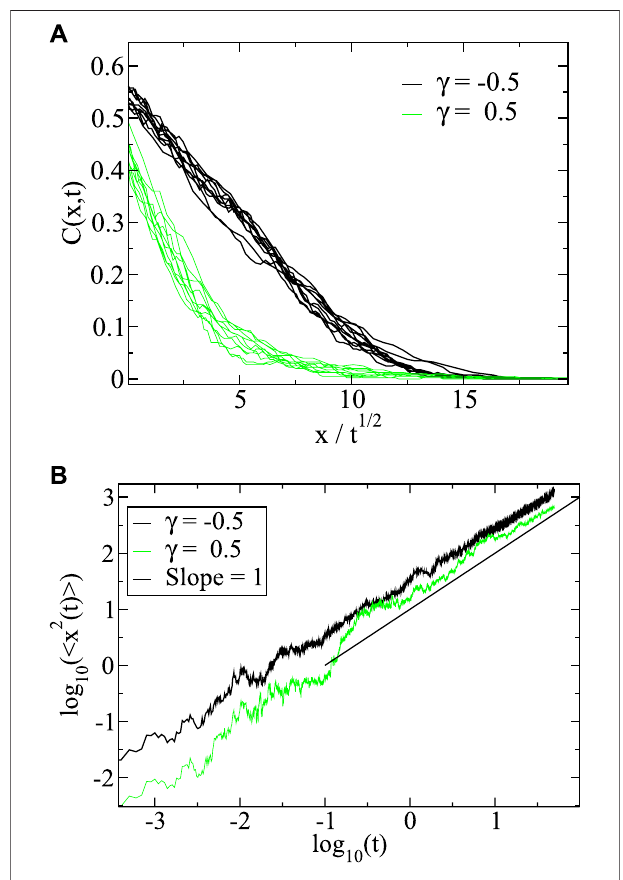
FIGURE1|(A) Evolutionofthesteppro fi lewhen c (cid:2) ± 1 / 2asafunction (cid:6) √ of x / t at different times. (B) The corresponding right-handed 〈 x 2 ( t ) 〉 , which is evaluated for x > 0 only. In these simulations N p (cid:2) 10000.